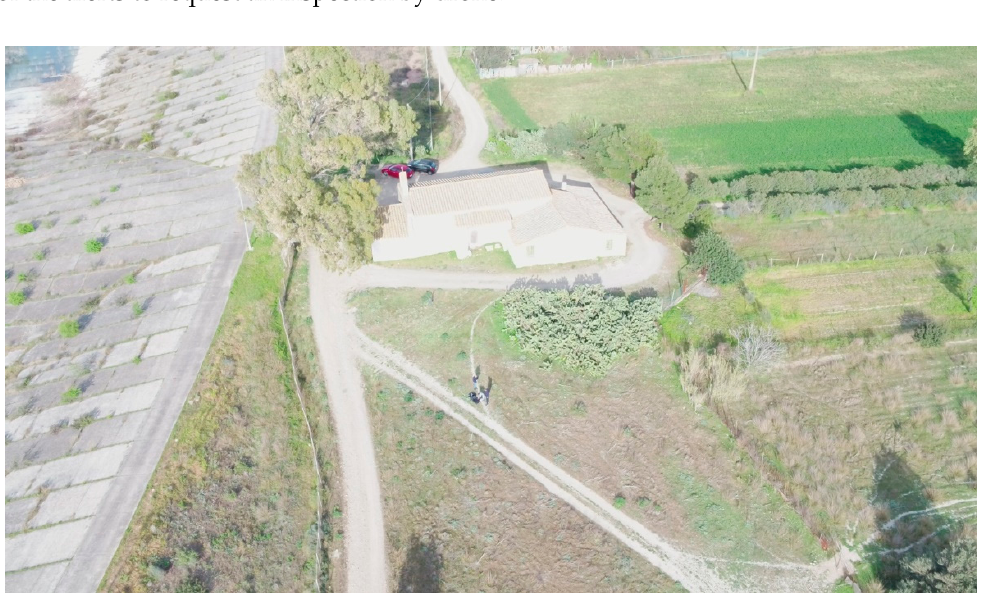
Figure 8. The mission is managed through the drone controller.